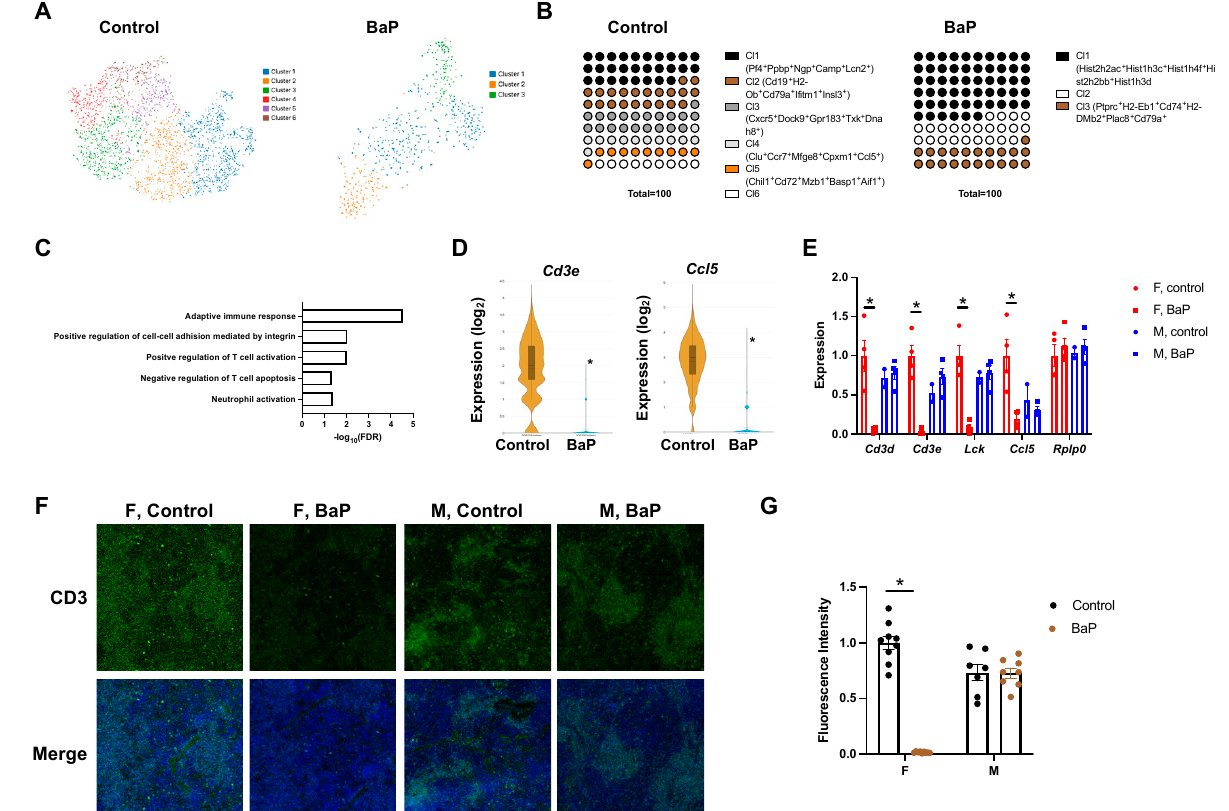
Figure 5. BaP treatment reduced cell-type diversity in the spleen of female MRL mice. ( A ) Cell clusters identified in control- or BaP-treated spleen from female MRL mice, with their individual percentage shown in ( B ). ( C ) Top gene ontology categories enriched in genes downregulated by BaP treatment in female MRL spleen, with example genes shown in ( D ). ( E ) Validation of BaP-downregulated, immune-associated genes by qPCR. ( F ) Immunostaining of CD3 in female or male control- or BaP- treated spleen (4 × ), with quantification in ( G ). F, female. M, male. Control, vehicle-treated. BaP, BaP-treated. * p < 0.05, Student’s t